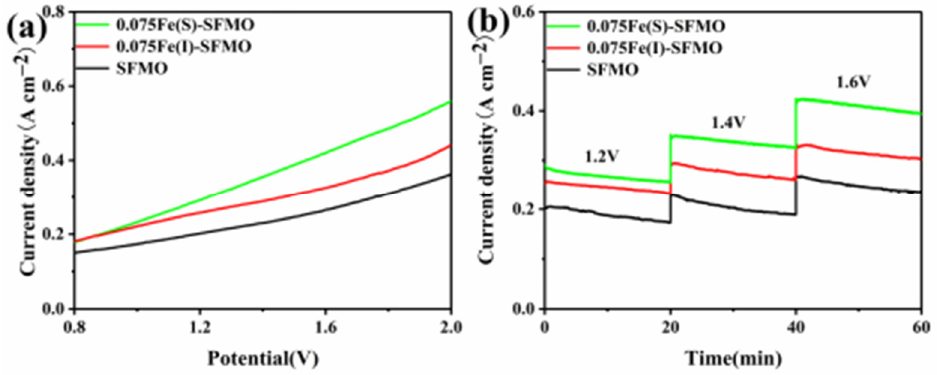
Figure 7. Current density of the samples. ( a ) I − V curves, ( b ) short − term performances of SFMO materials.